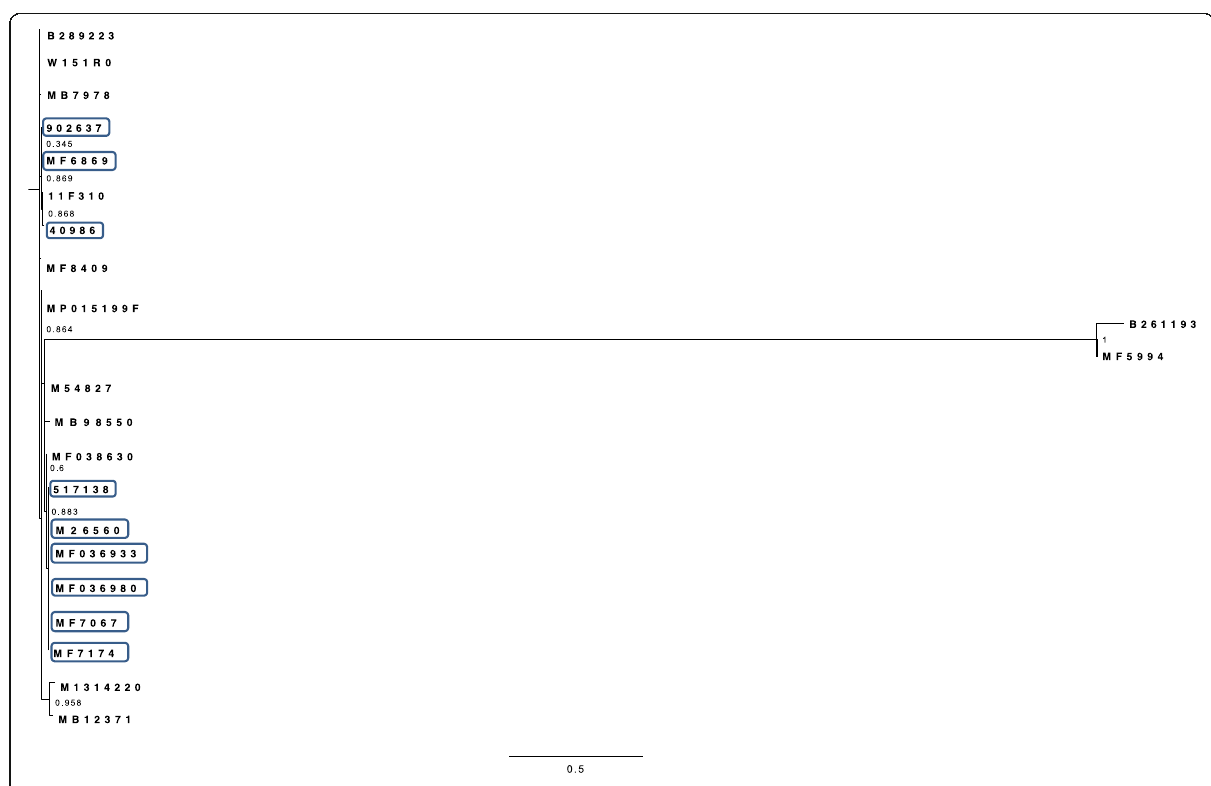
Fig. 4 Maximum likelihood phylogenetic tree of Salmonella Dublin strains based on prophages SNPs using